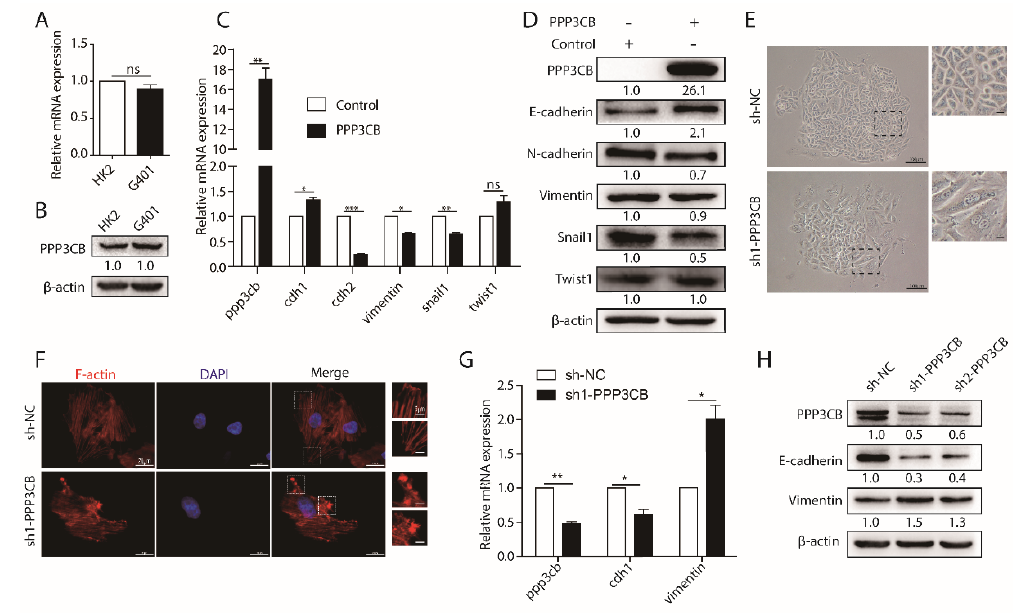
Figure 2. PPP3CB suppresses EMT of tumor cells. ( A , B ) Expression of PPP3CB in HK2 and G401 cells was detected by QPCR and western blotting. ( C ) Control or PPP3CB overexpressed G401 cells were subjected to QPCR with indicated genes. Data represents the mean ± SEM of three independent experiments. * p < 0.05, ** p < 0.01, and *** p < 0.001 ( D ) G401 cells infected with a lentivirus expressing Control and PPP3CB, subjected to western blotting with the indicated antibodies. ( E ) The images of G401 cells treated with sh-negative control (sh-NC) and sh1-PPP3CB, scar bar: 100 µ m. The top-right subfigure of panel E means the magnified part, the scale bar is 35 µ m. (F) Immunofluorescent staining of sh-NC and sh1-PPP3CB was assayed, red represents phalloidin, blue stains nucleus, scale bar is 20 µ m. The top-right subfigure of panel F means the magnified part, the scale bar is 5 µ m. ( G ) G401 cells with or without the depletion of PPP3CB, subjected to QPCR with indicated genes. Data represents the mean ± SEM of three independent experiments. * p < 0.05, ** p < 0.01. ( H ) G401 cells were treated with lentivirus vectors encoding two shRNA targeting PPP3CB or sh-NC, subjected to western blotting with indicated antibodies.